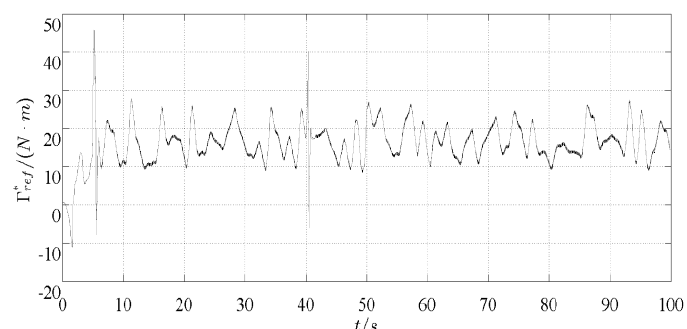
Figure 9. Reference value of electromagnetic torque Γ 𝑟𝑒𝑓 Figure 10. Wind energy conversion coefficient value C p when actuator fails. Figure 10. Reference value of electromagnetic torque Γ ∗